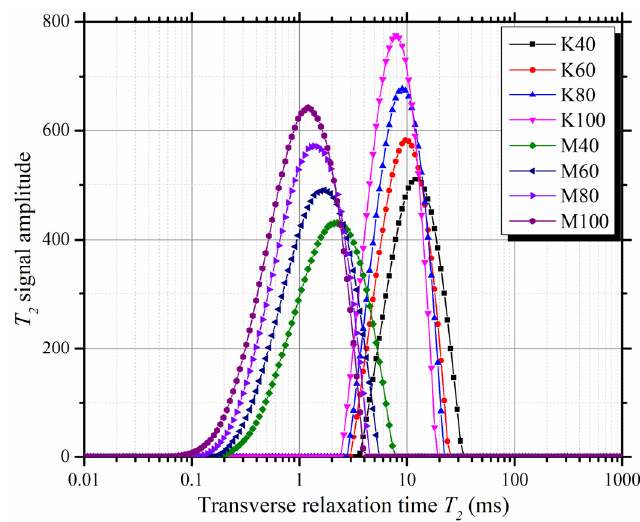
Figure 2. The T 2 spectra of kaolinite-quartz and montmorillonite-quartz saturated mixtures. From left to right, curves with different colors and symbols with different shapes indicate T 2 spectra of M100, M80, M60, M40, K100, K80, K60, and K40, respectively. According to T 2 p , T 2 spectra could be divided into two groups. The group on the left and right are the T 2 spectra of montmorillonite-quartz and kaolinite-quartz saturated mixtures, respectively.